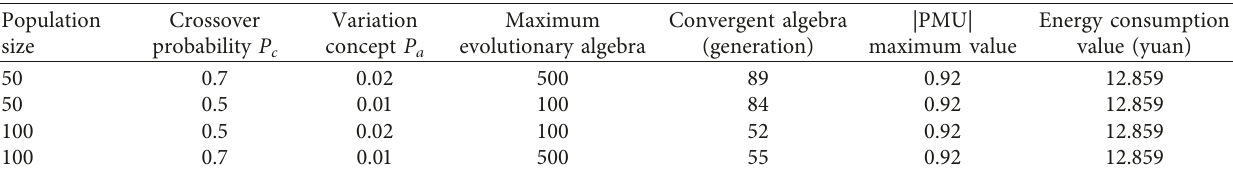
Table 6: Parameter Settings and effects when m � 10 and n � 4.